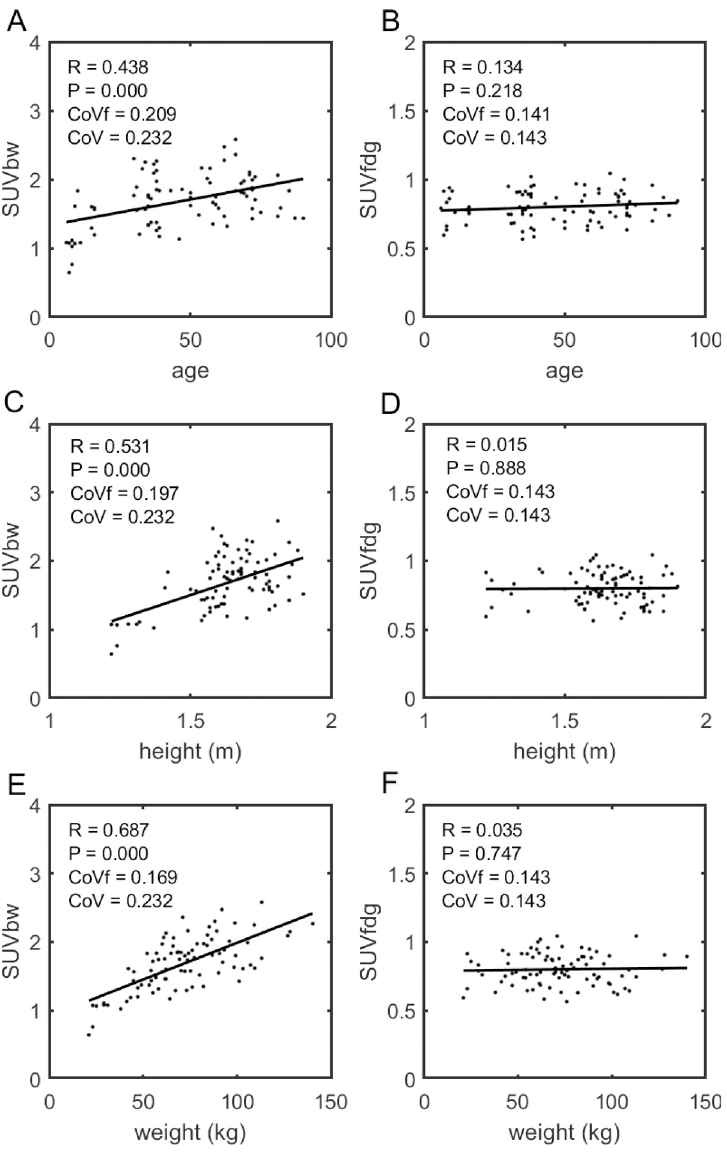
Fig 5. Blood test data, SUVs as a function of age, height and weight. For the independent test data, these scatter plots compare the correlations in blood SUV bw (column A, C, E) and SUV fdg (column B, D, F) measurements with age (row A, B), height (row C, D) and weight (row E, F). Note, blood concentrations were not measured in the training cohort and played no part in determining the BHN function used to calculate these SUV fdg